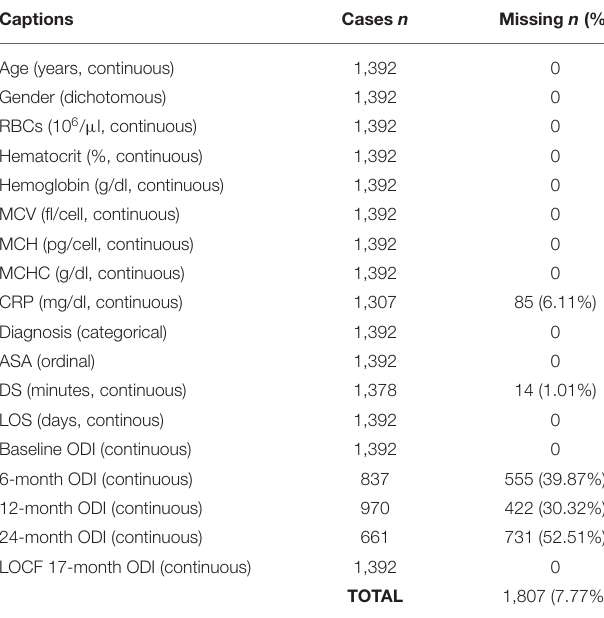
TABLE 1 | Structure and missing data of the study group dataset. TABLE 2 | Baseline demographic and biochemical characteristics of the study